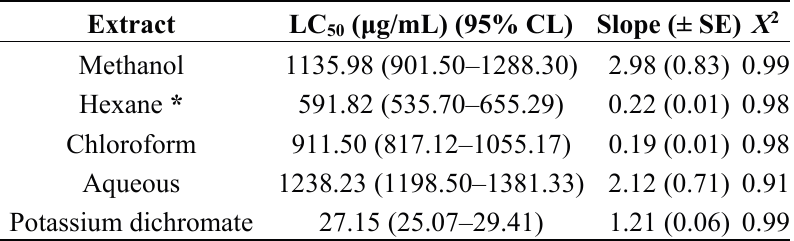
Table 6. Toxic effect of Bryopsis pennata extracts against nauplii of brine shrimp Artemia salina .